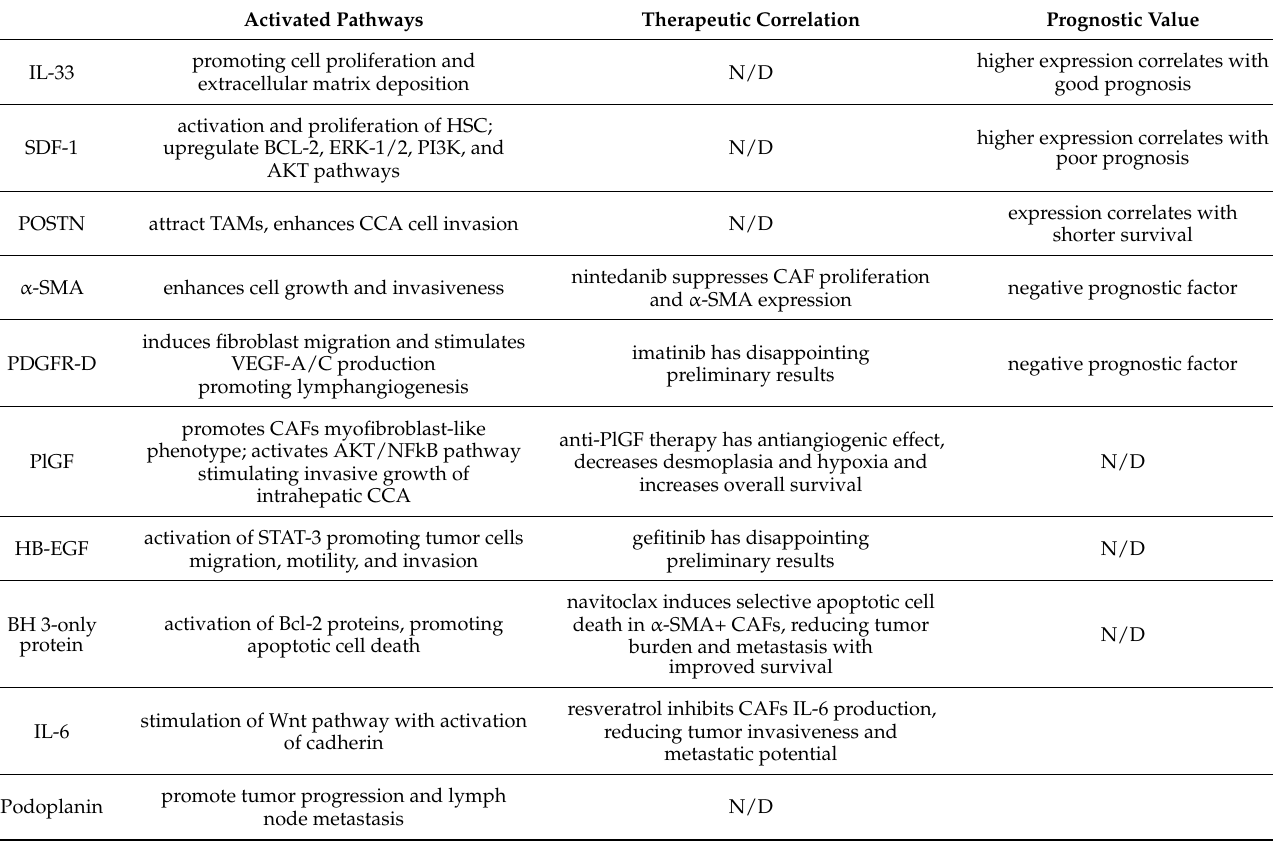
Table 1. Molecules expressed by CAFs and their involvement in treatments and